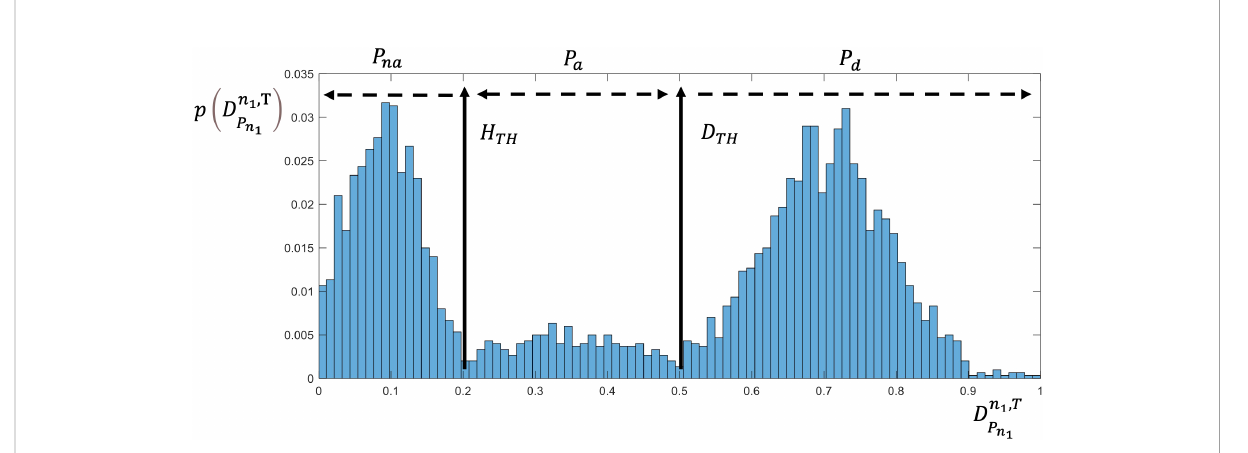
FIGURE 4 Cell state as derived by the death rate